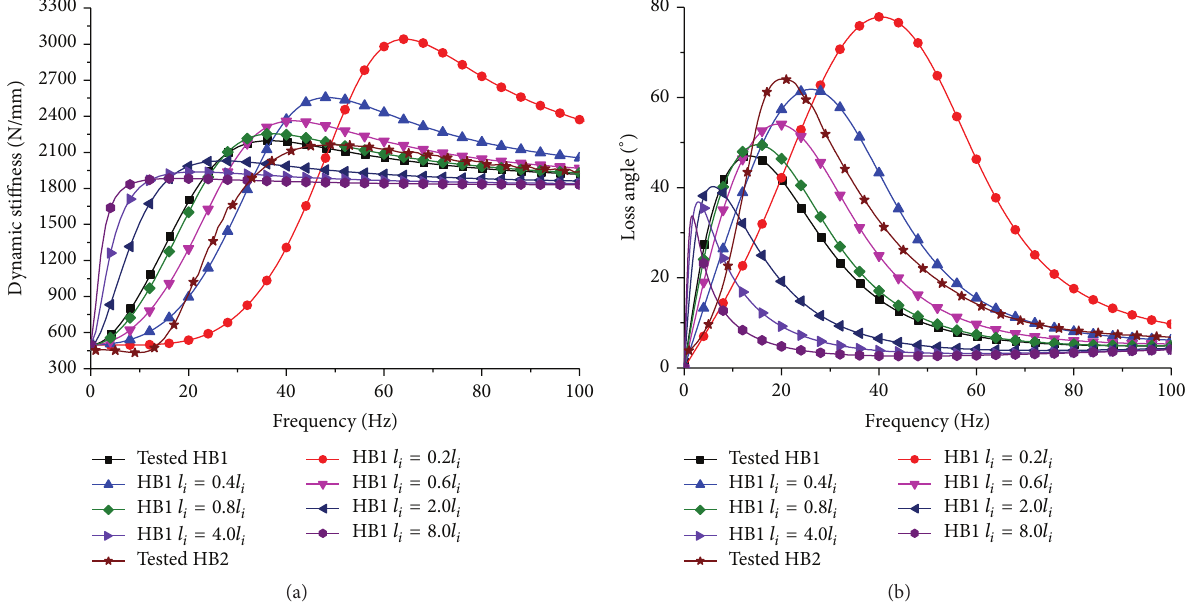
Figure 11: Calculated dynamic performances of HDB (excitation amplitude: 0.8 mm). (a) Dynamic stiffness. (b) Loss angle.